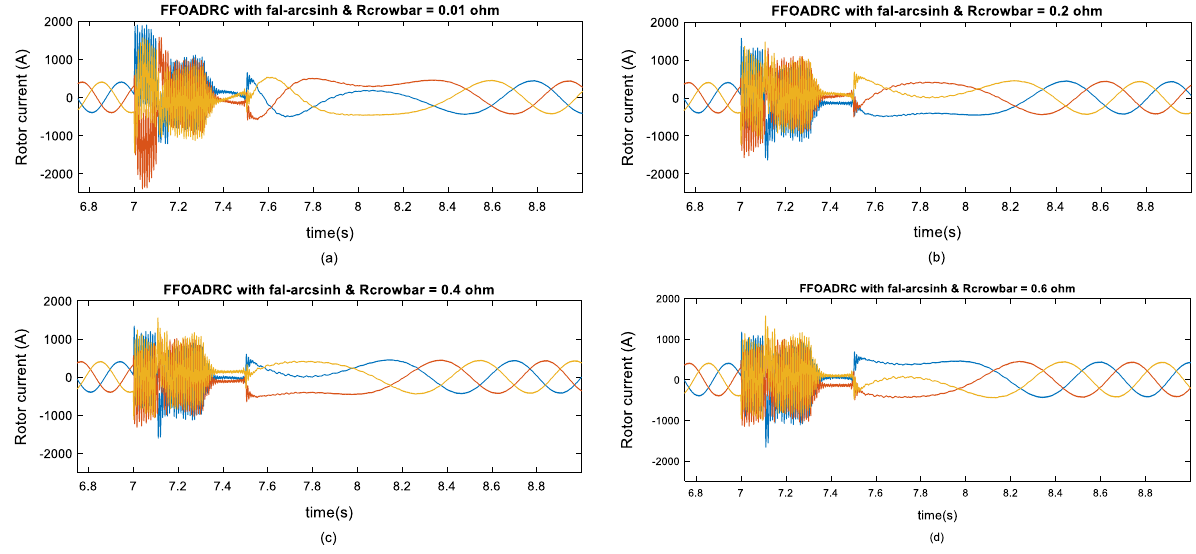
Fig. 33 Rotor current of the DFIG during asymmetrical voltage sag for different values of R crowbar . ( a ) R crowbar R crowbar 0.4 ohm, and ( d ) R crowbar =